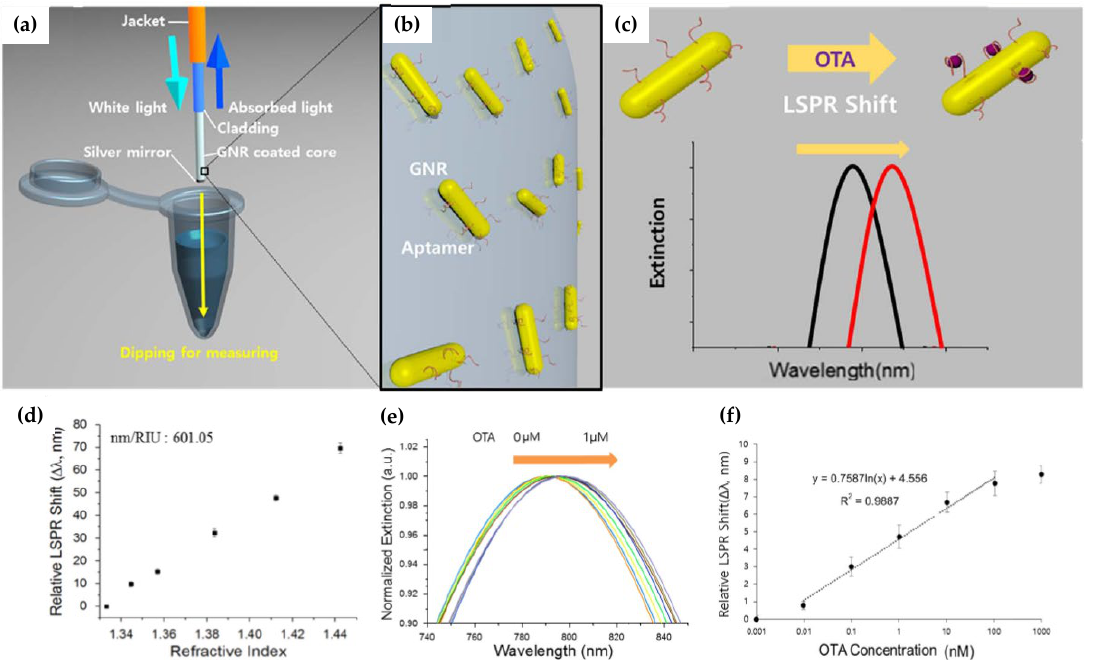
Figure 6. Schematic of a tip OFB: ( a ) components and measurement procedure; ( b ) magnification of the sensor surface biofunctionalized with aptamer-modified GNR; ( c ) schematization of LSPR wavelength shift when the analyte, in this case, OTA, is recognized by the specific aptamer; ( d ) GNR-coated tip OFS response to RI; ( e ) LSPR wavelength shift with different concentrations of OTA, and ( f ) experimental response of the biosensor to different concentrations of OTA with respective linear fitting (images adapted with permission from ref. [53]. Copyright ©2018, with permission from Elsevier).